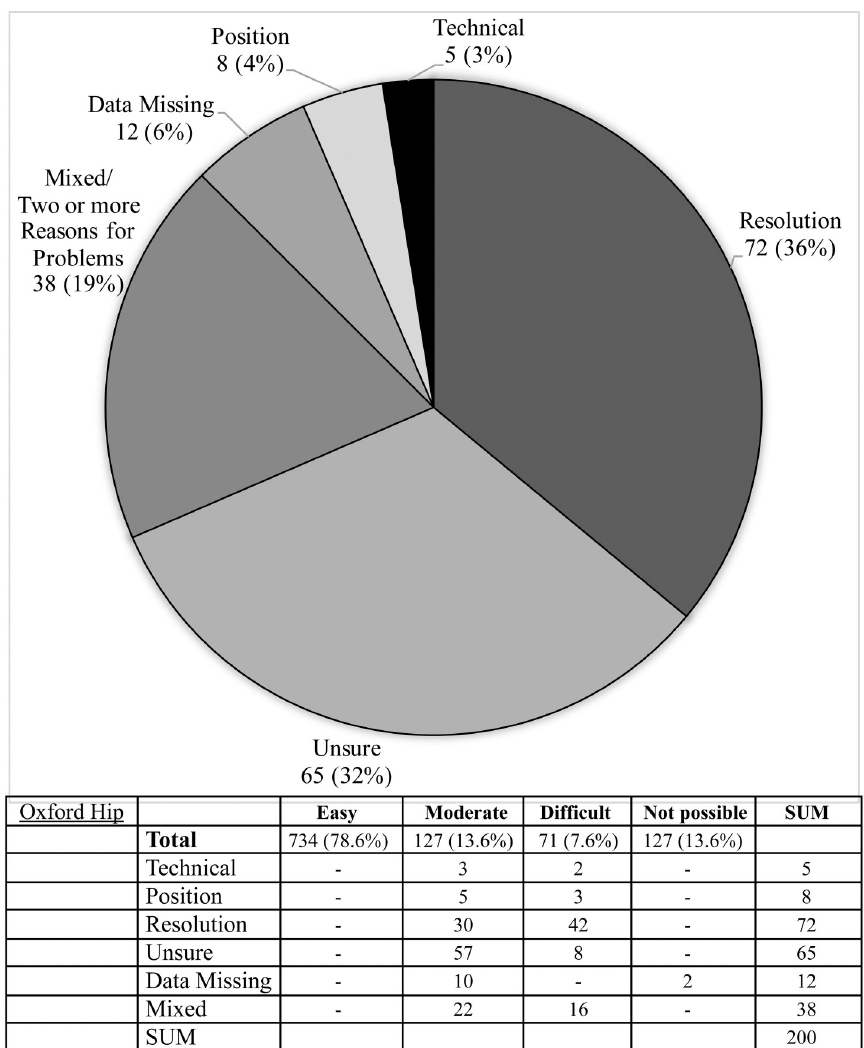
Fig 11. Difficulties reported during image assessment of the Oxford hip method. Difficulties were grouped as those due to technical difficulties e.g. landmark(s) lying outside of the edge of the image; resolution issues, insufficient resolution to assess image easily; positioning—landmark not visible, or not clearly visible due to limb rotation or shadowing; and if rater was ‘unsure’ due to problems with method